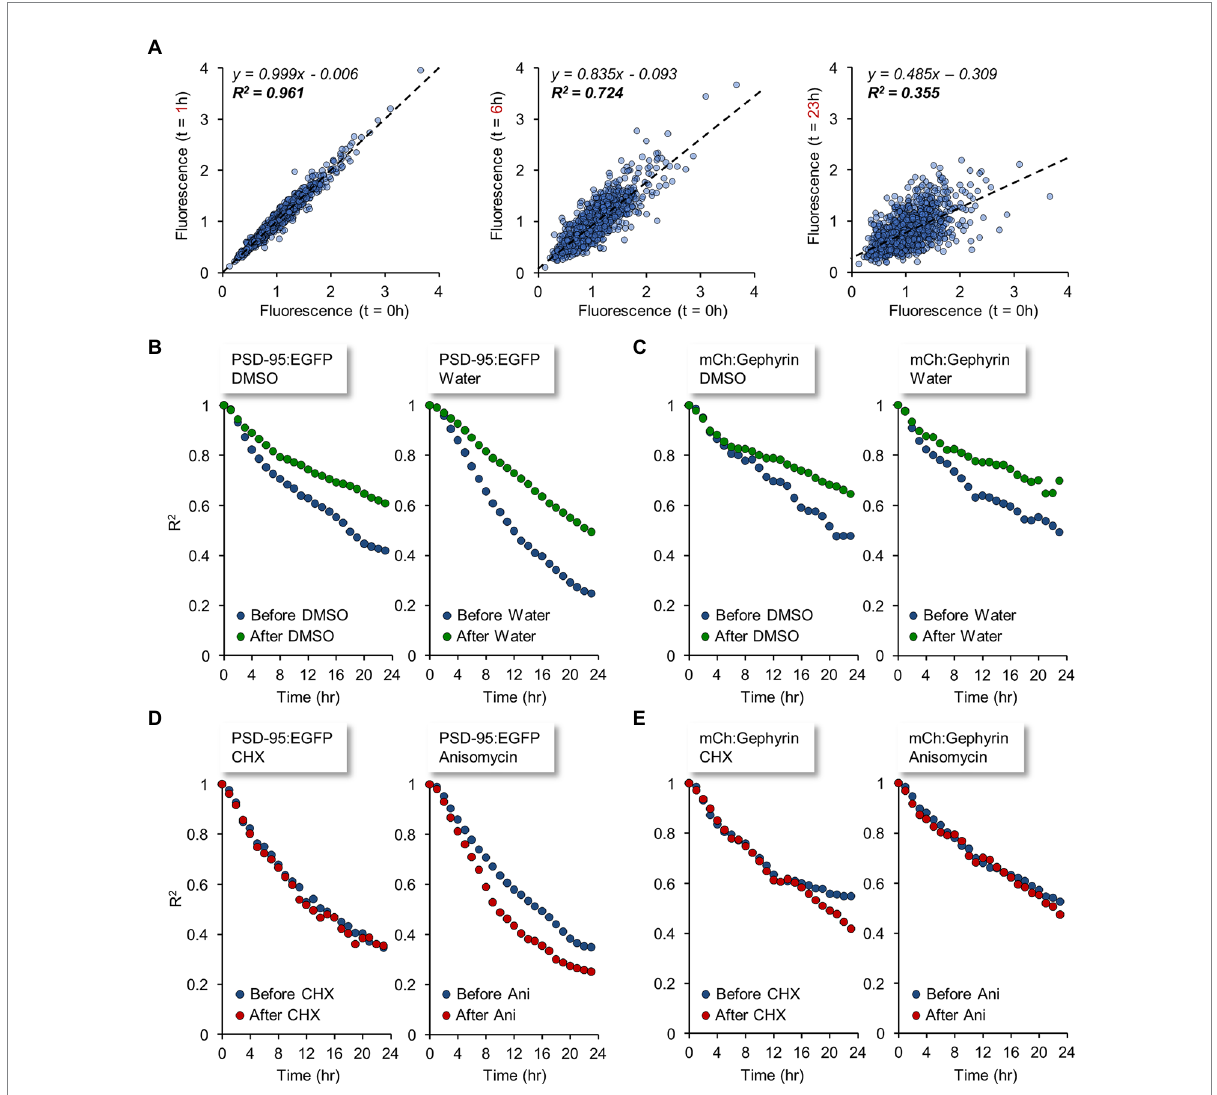
FIGURE 7 Synaptic tenacity is impaired by interruptions in the supply of newly synthesized proteins. Individual PSD-95:EGFP and mCherry:Gephyrin puncta were tracked over time and the normalized fluorescence of each punctum was compared to its normalized fluorescence at the start of each 24 hour window: the start of the baseline recording, and time of PSI (CHX/DMSO) or carrier solution (DMSO/water) addition, both denoted by t = 0. (A) The normalized fluorescence values of each synapse at time t = 1, t = 6, t = 23 hours are plotted relative to the normalized fluorescence values at t = 0 (in this dataset, the time of CHX addition). Dashed lines indicate linear regression fits. Equations of the fits and coefficient of determination (R 2 ), signifying the goodness of fit with the original values, are indicated in each plot. Data are from PSD-95:EGFP puncta (1,051 synapses). Linear fits at later times typically display lower R-squared (goodness-of-fit) values as well as shallower slopes. (B–E) The coefficient of determination (R 2 ) is plotted as a function of the time interval, providing a measure of the rates of synaptic configuration change. (B) PSD-95:EGFP before (blue) and after (green) exposure to carrier solutions. (C) mCherry:Gephyrin before (blue) and after (green) exposure to carrier solutions. (D) PSD-95:EGFP before (blue) and after (red) exposure to PSIs. (E) mCherry:Gephyrin before (blue) and after (red) exposure to PSIs. Data from same experiments shown in Figure